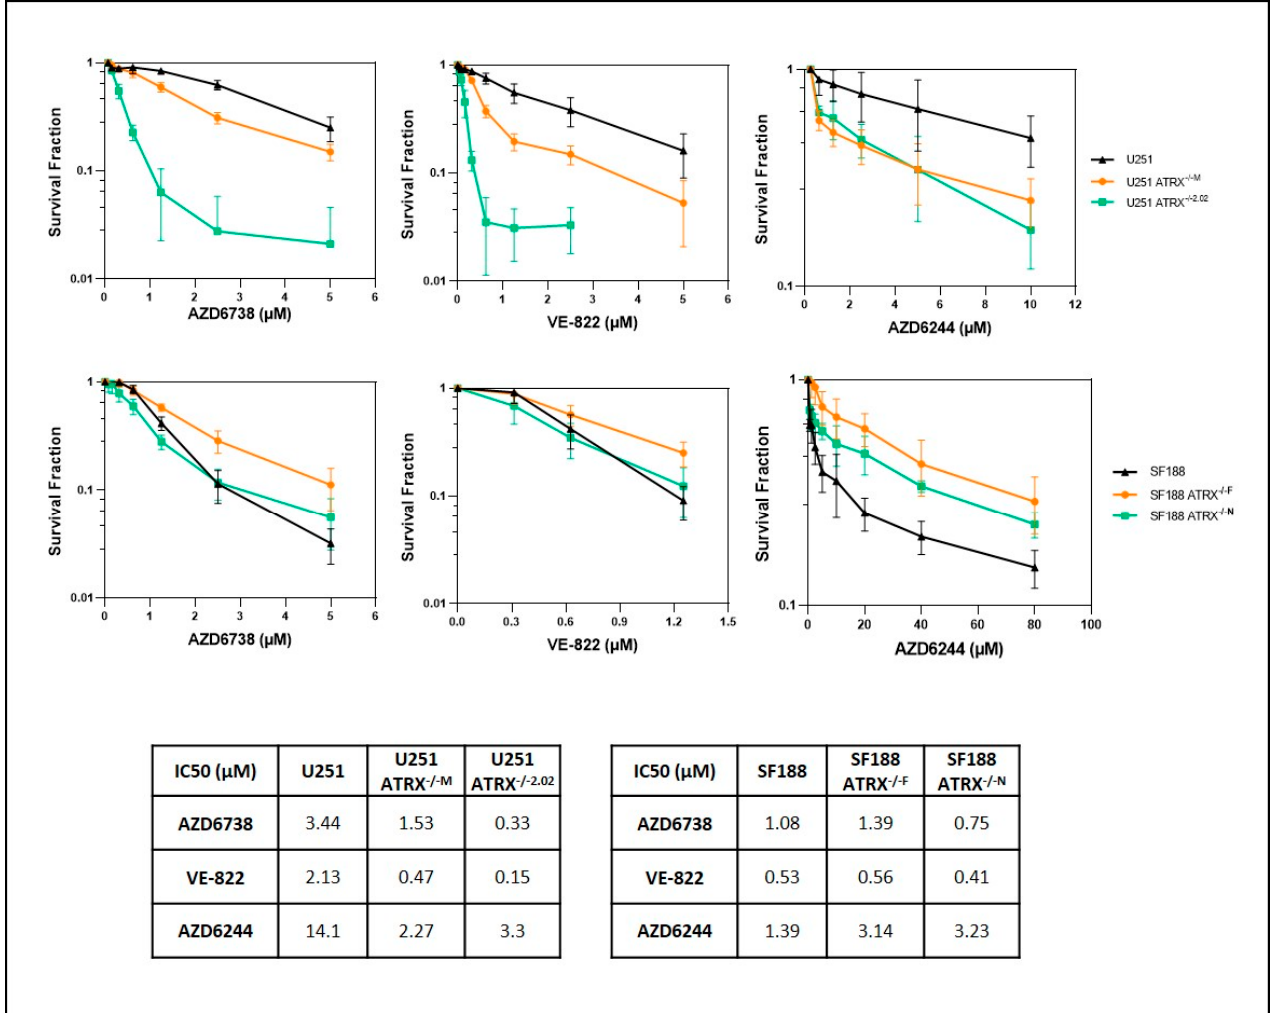
Figure 5. ALT-positive, ATRX-deficient U251 cells display an increased sensitivity to ATR inhibition. U251 and SF188 cells were treated with various doses of AZD6244, VE-822, or AZD6738 for 5 days, cell survival was normalized with vehicle control. ATR inhibitors (AZD6738 and VE-822) decreased growth of U251 (ALT+) (top row), but not in cell line SF188 (ALT-) (bottom row). MEK inhibition (AZD6244, selumetinib) had a modest effect on growth in U251 as well. IC50 of drugs are listed at the bottom. Data are presented as mean ± s.d.